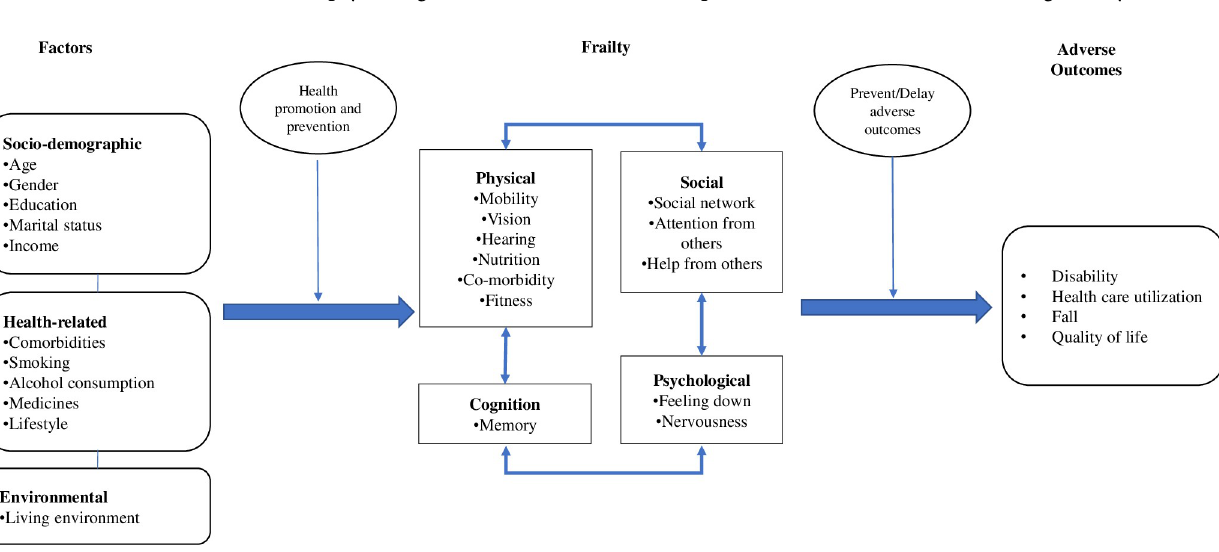
Fig 1. Conceptual